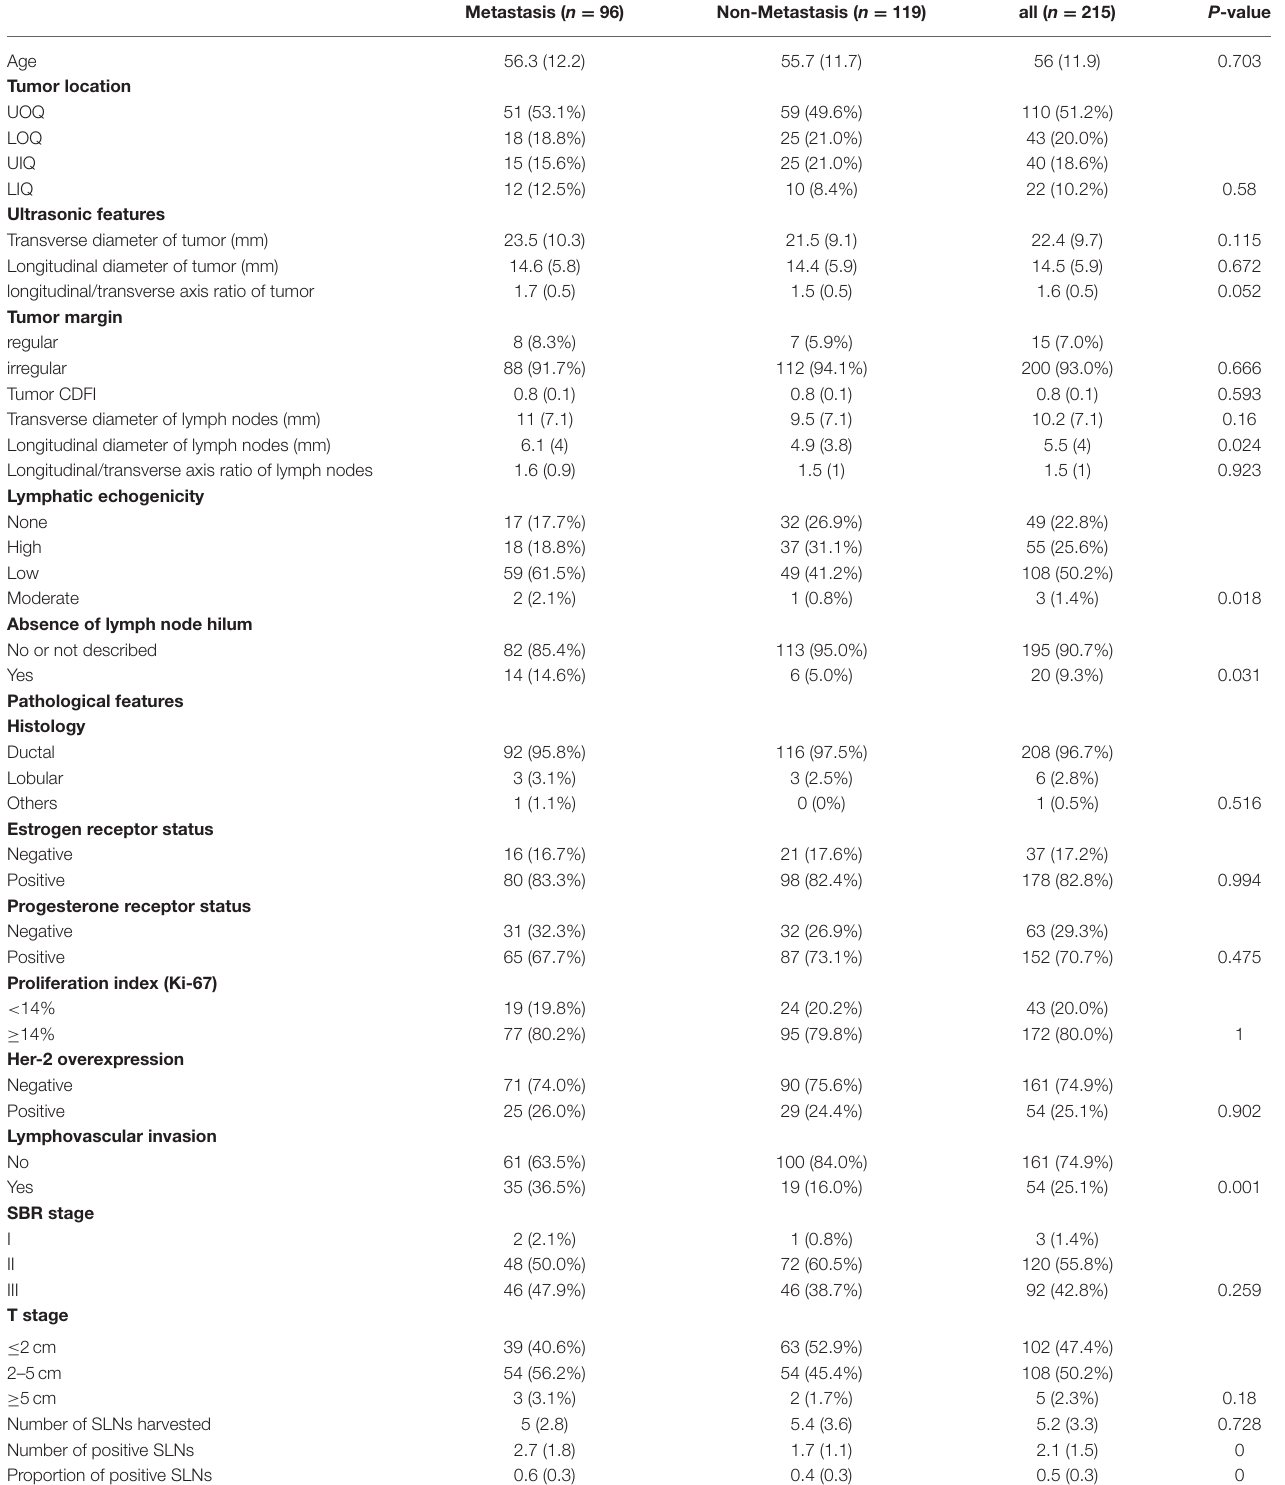
TABLE 1 | Differences in clinicopathological characteristics between the patients with and without NSLNs